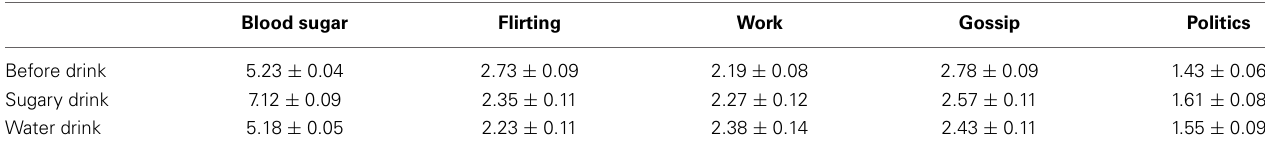
Table 1 | The descriptive results of Experiment 2 (mean ± SE).